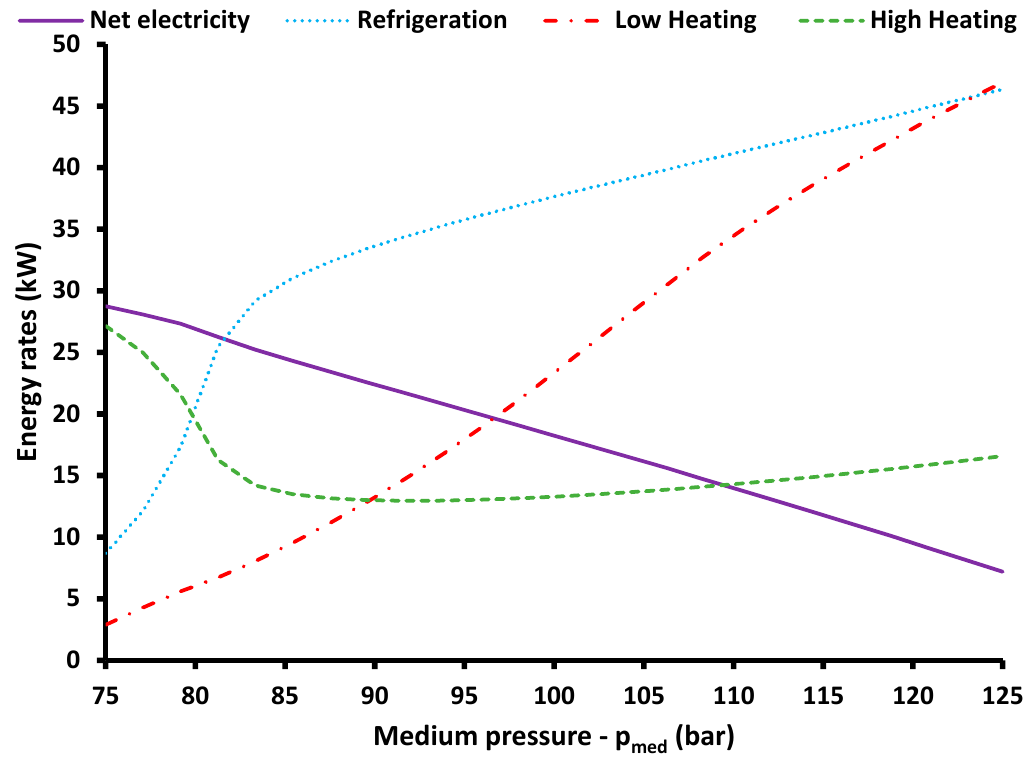
Figure 8. Useful energy products for different values of the medium pressure.